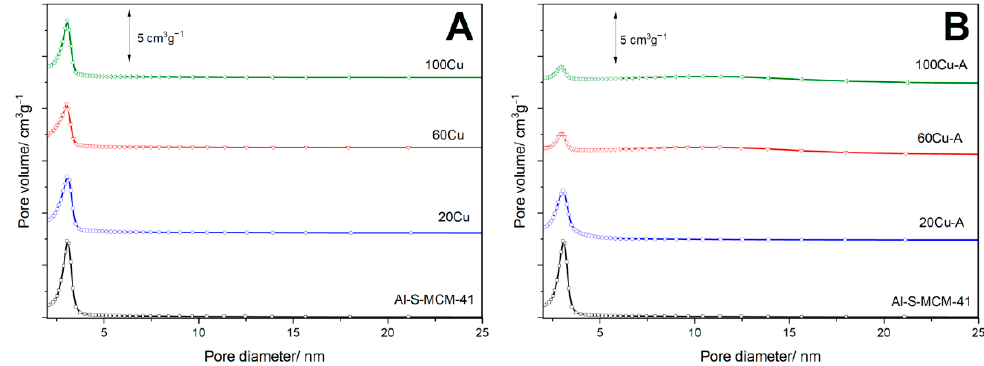
Figure 3. Pore size distributions of the of the Al-S-MCM-41 sample and its modifications with copper obtained by TIE ( A ) and TIE-NH 3 ( B ) methods. Table 2. Textural parameters, chemical composition, and surface acidity of the copper modified Al-S-MCM-41 samples. Sample Code Sample